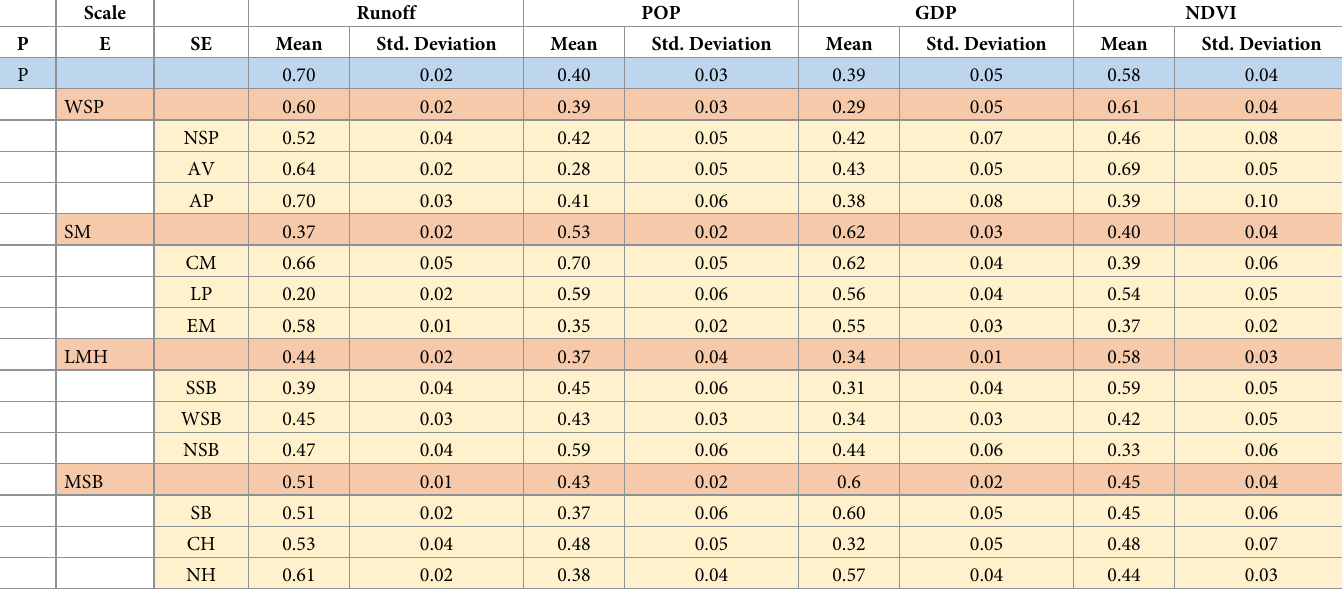
Table 2. Statistical summary of the local regression coefficients of soil conservation at the provincial (P) scale, ecoregion (E) scale, and subecoregion (SE) scale (p < 0.05). Scale Runoff POP GDP NDVI P E SE Mean Std. Deviation Mean Std. Deviation Mean Std. Deviation Mean Std. Deviation P 0.70 WSP